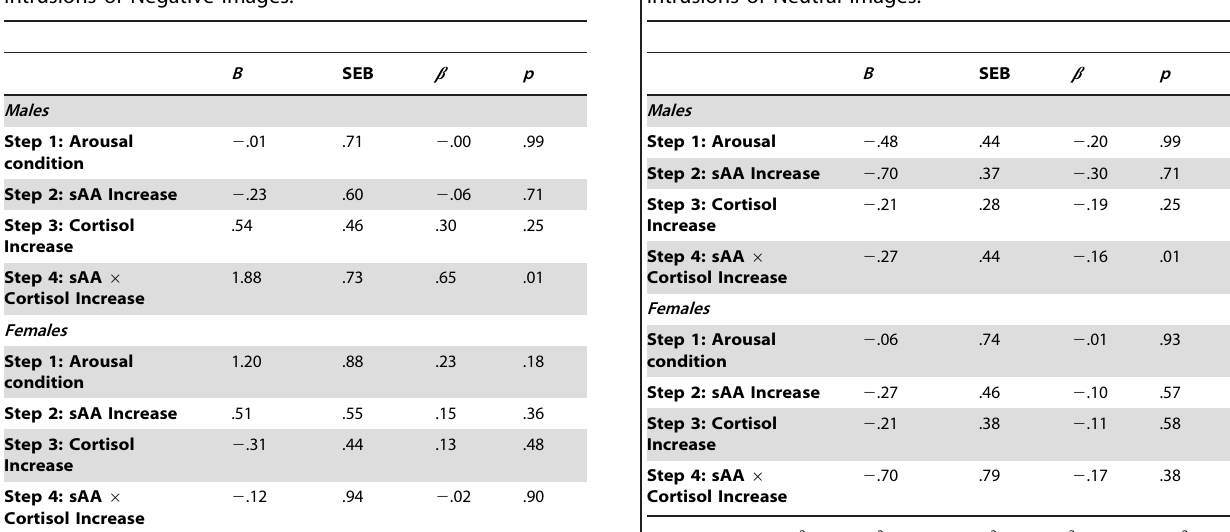
Table 5. Summary of Hierarchical Regression Models for Intrusions of Negative Images.